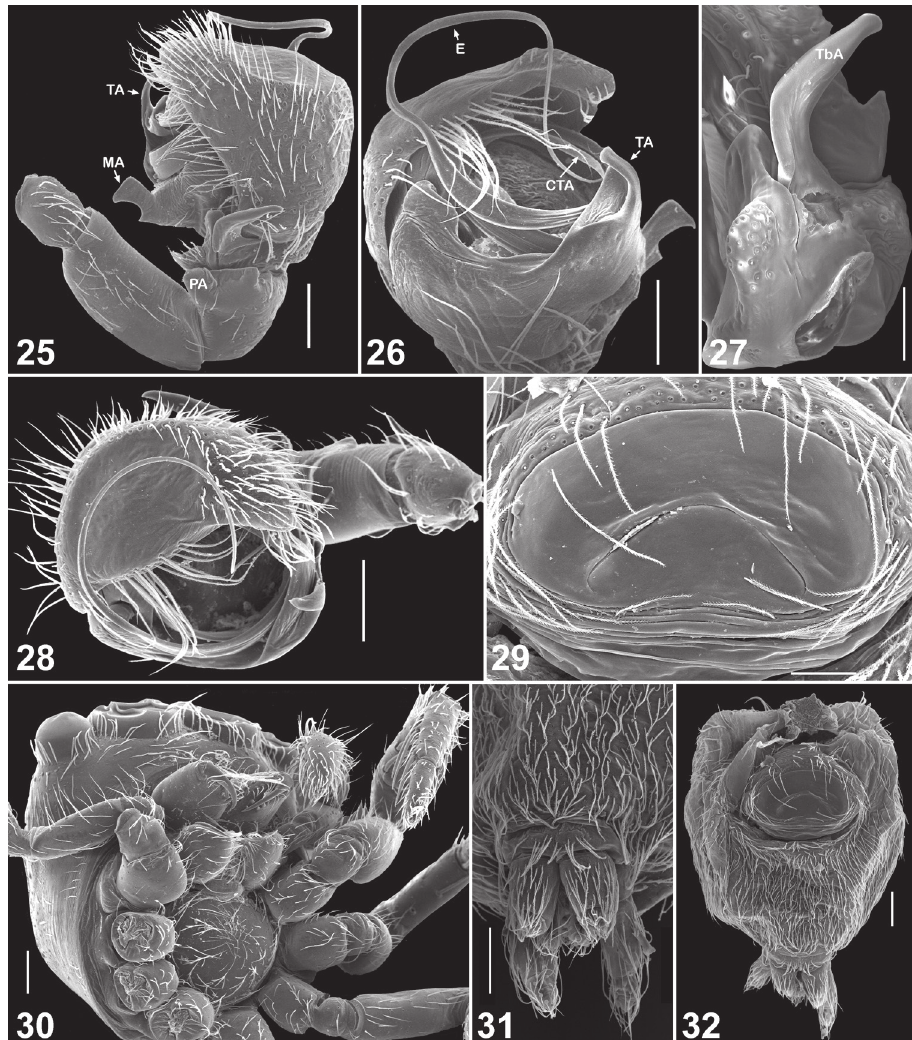
Figures 25–32. Copulatory organs and somatic characters of Eupoa lehtineni sp. n. 25 male palp, ret- rolateral view 26 ditto, median view 27 male tibial apophysis, retrolateral view 28 male palp, apical view 29 epigyne, ventral view 30 female carapace, ventral view 31 female spinnerets, ventral view 32 female abdomen, ventral view. Abbreviations as explained in ‘Material and methods’. Scale bars: 50 μm ( 27, 29 ), 0.1 mm ( 25–26 , 28 , 30–32